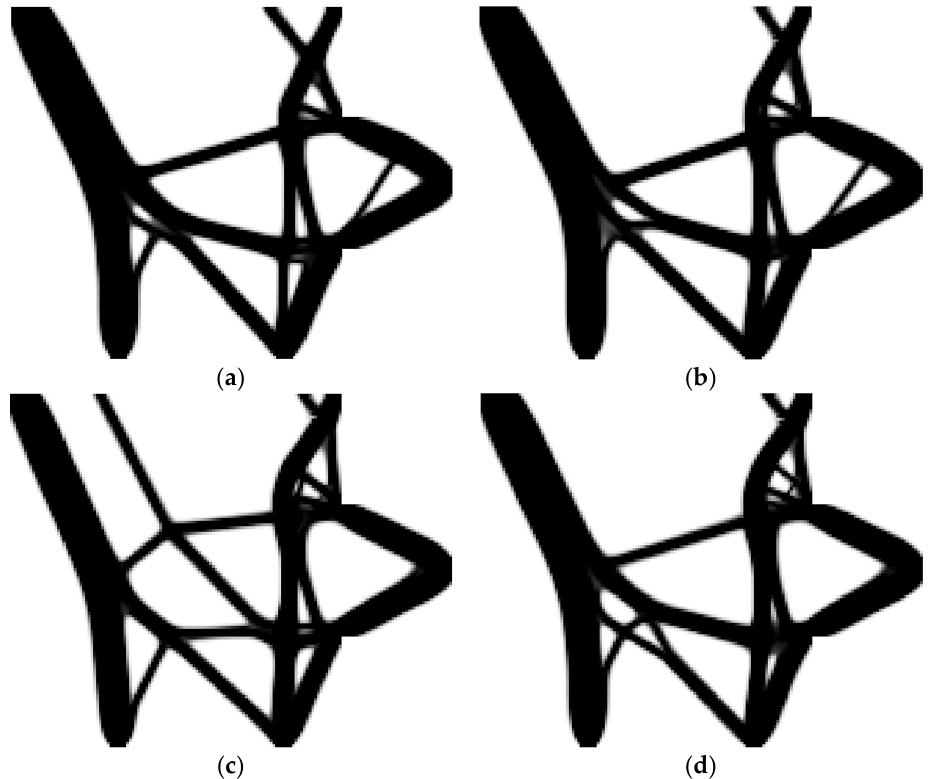
Figure 11. Path generators obtained with different [ δ ] and [ γ ]: ( a ) 0.1, ( b ) 0.01, ( c ) 0.001, ( d ) 0.0001. Table 3. Desired and undesired displacements of the four design results shown in Figure 11.